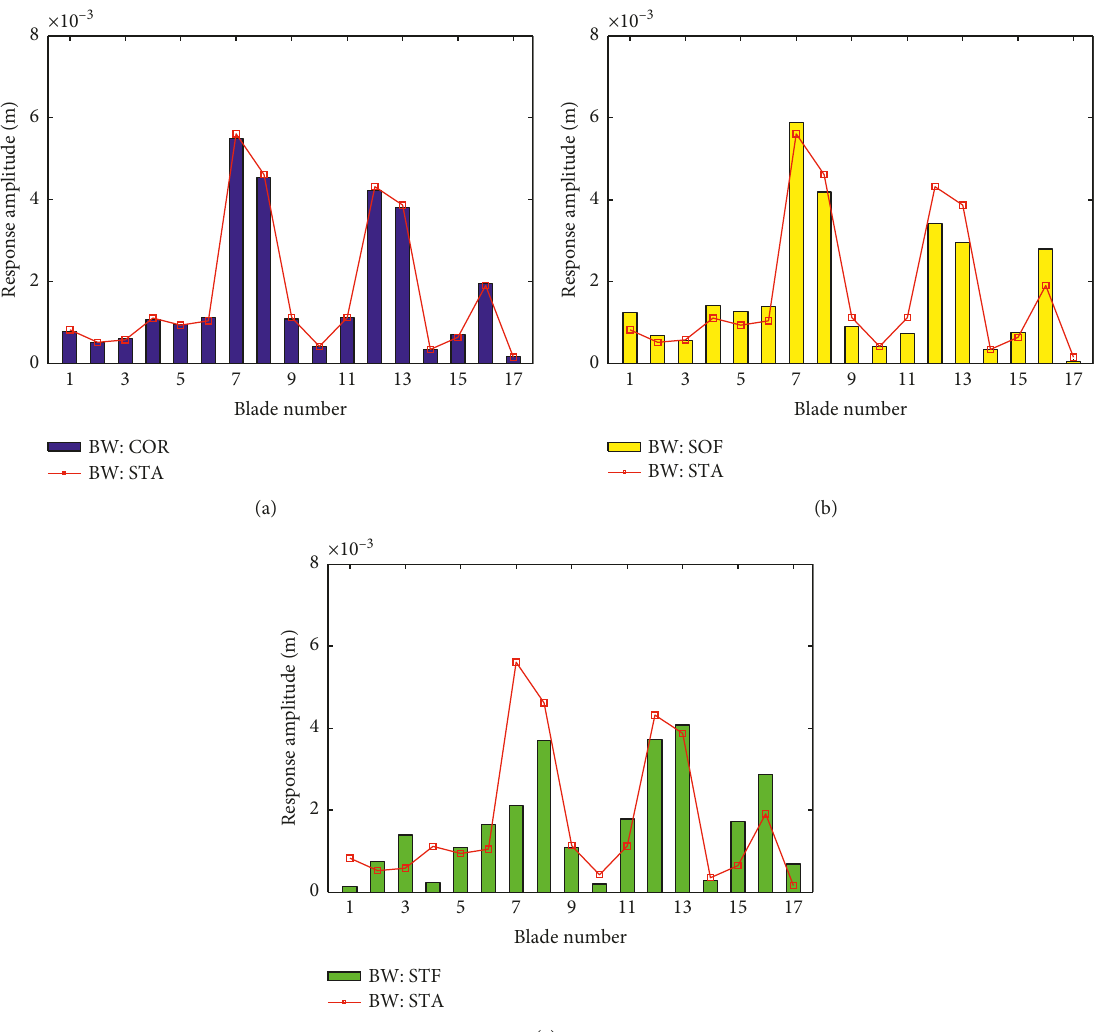
Figure 12: Response amplitudes of blade tips of mistuned bladed disk excited by a 3EO backward traveling wave excitation: (a) case COR, (b) case SOF, and (c) case STF.